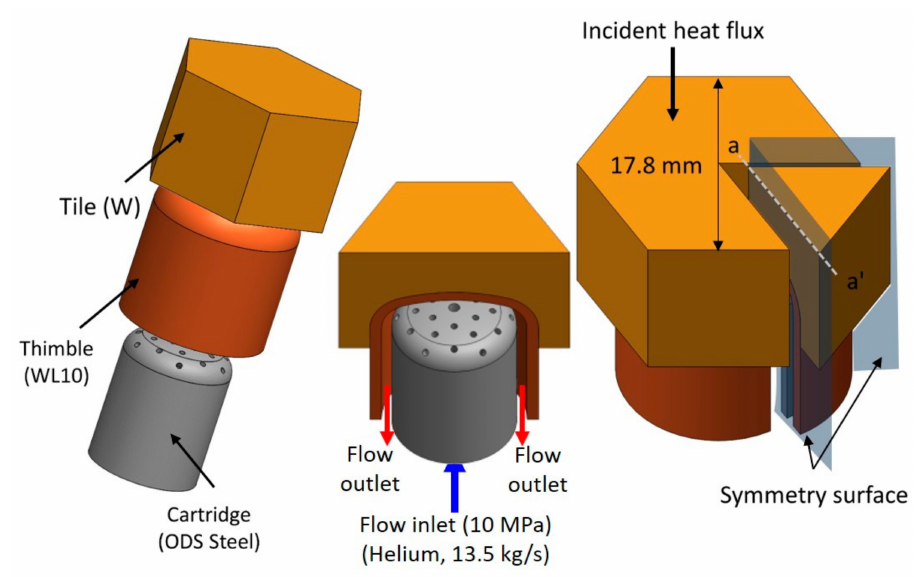
Figure 1. Schematic of the divertor module with multi-array impingement jet (MAIJ) cooling, indicating sizes, materials, and boundary